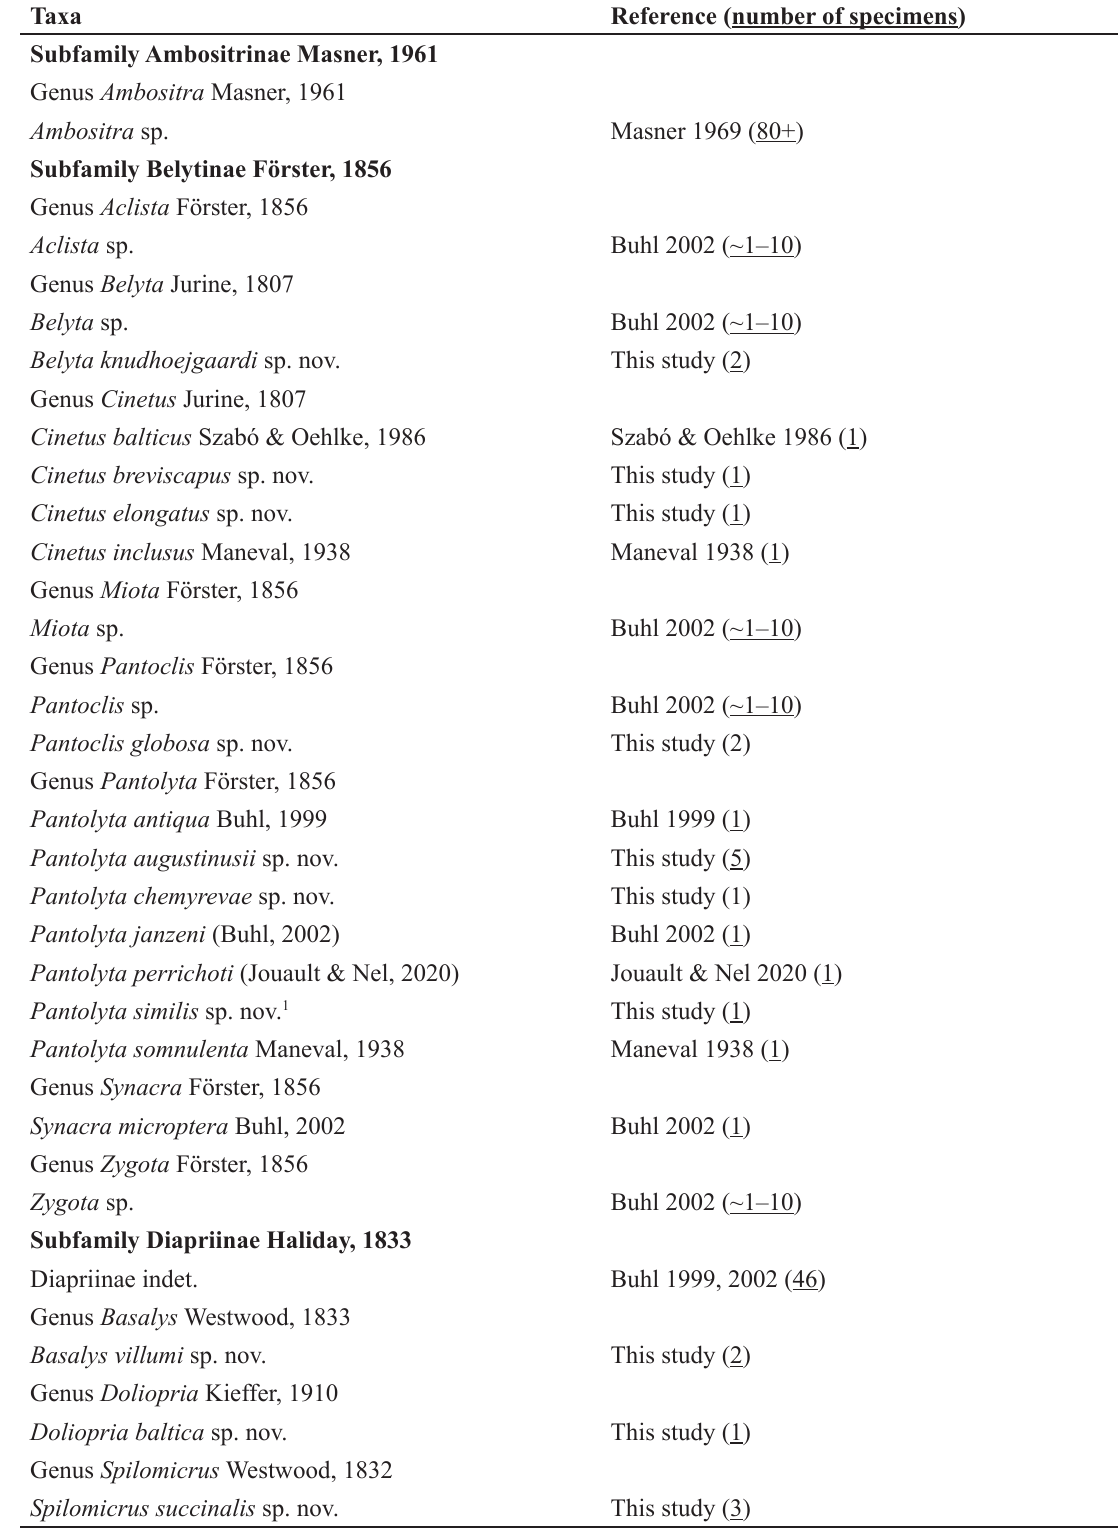
Table 1. Fossil record of the Diapriidae Haliday, 1833 in Baltic amber ( 1 Pantolyta similis sp. nov. was originally identified as P. macrocera (Thomson,